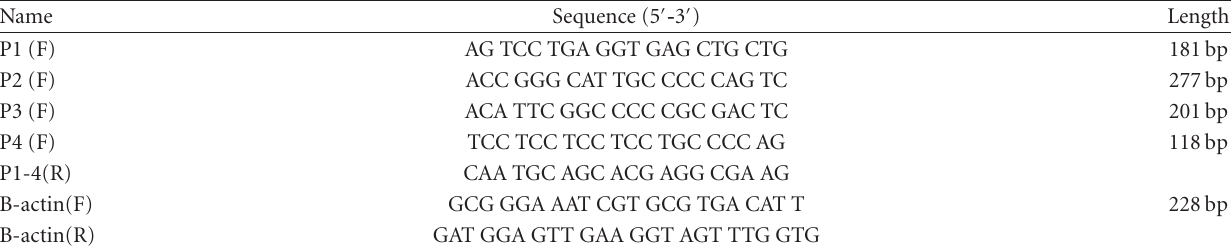
Table 2: Primers for promoter-specific expression of the IGF-II gene and internal control.